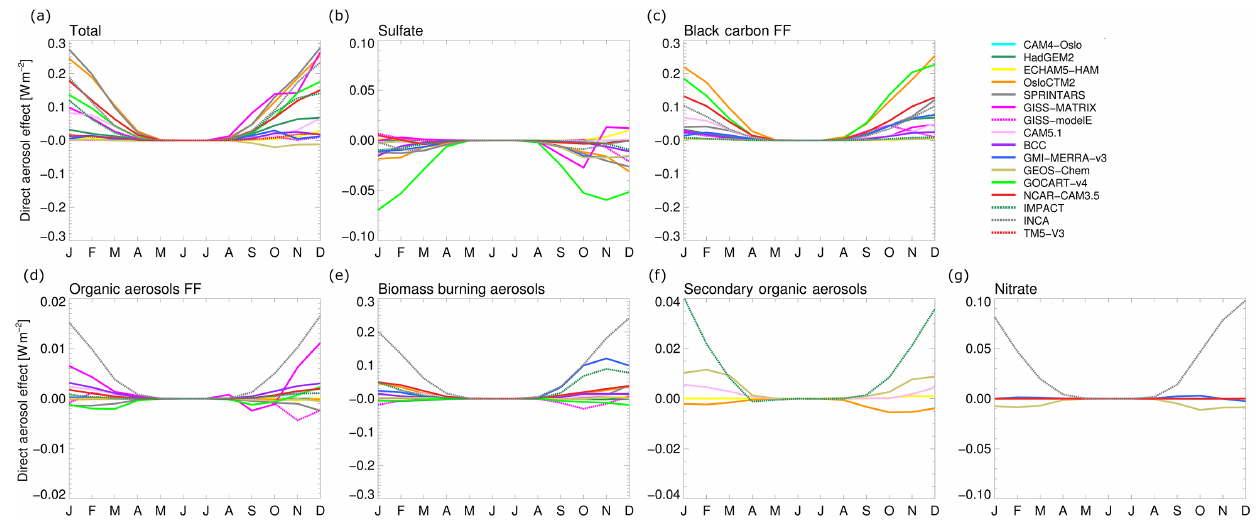
Figure 17. Antarctic mean (70–90 ◦ S) seasonal cycle of (a) the total DAE and the DAE for (b) sulfate, (c) BC FF, (d) OA FF, (e) BB, (f) SOA, and (g) nitrate. Note the different axes.